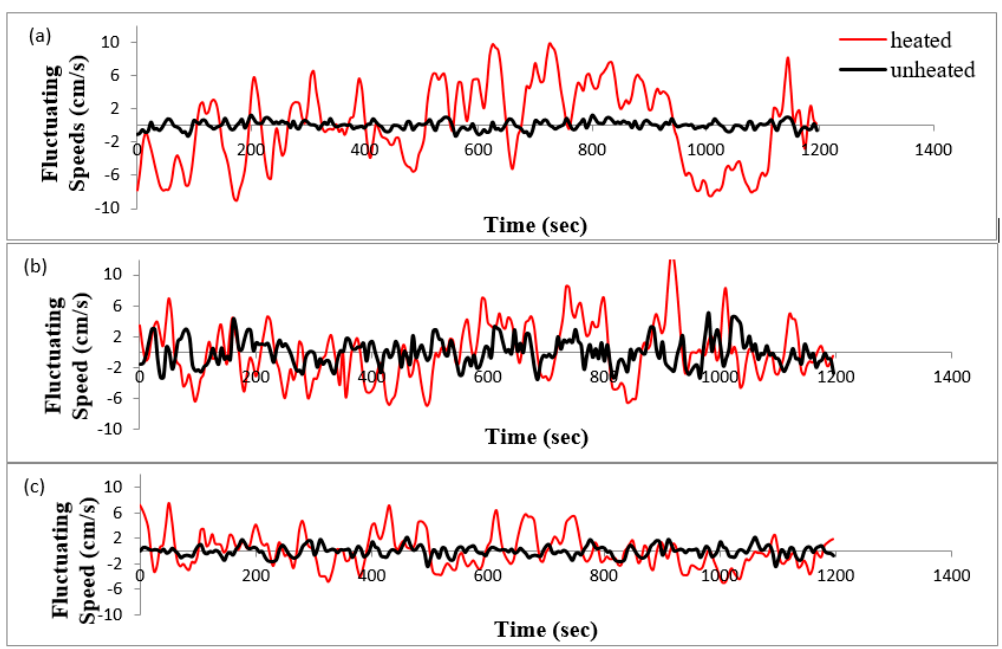
Figure 8. Comparison of the fluctuating speed in seat ( a ) 9D; ( b ) 7D; and ( c ) 6D with heated and unheated manikins.